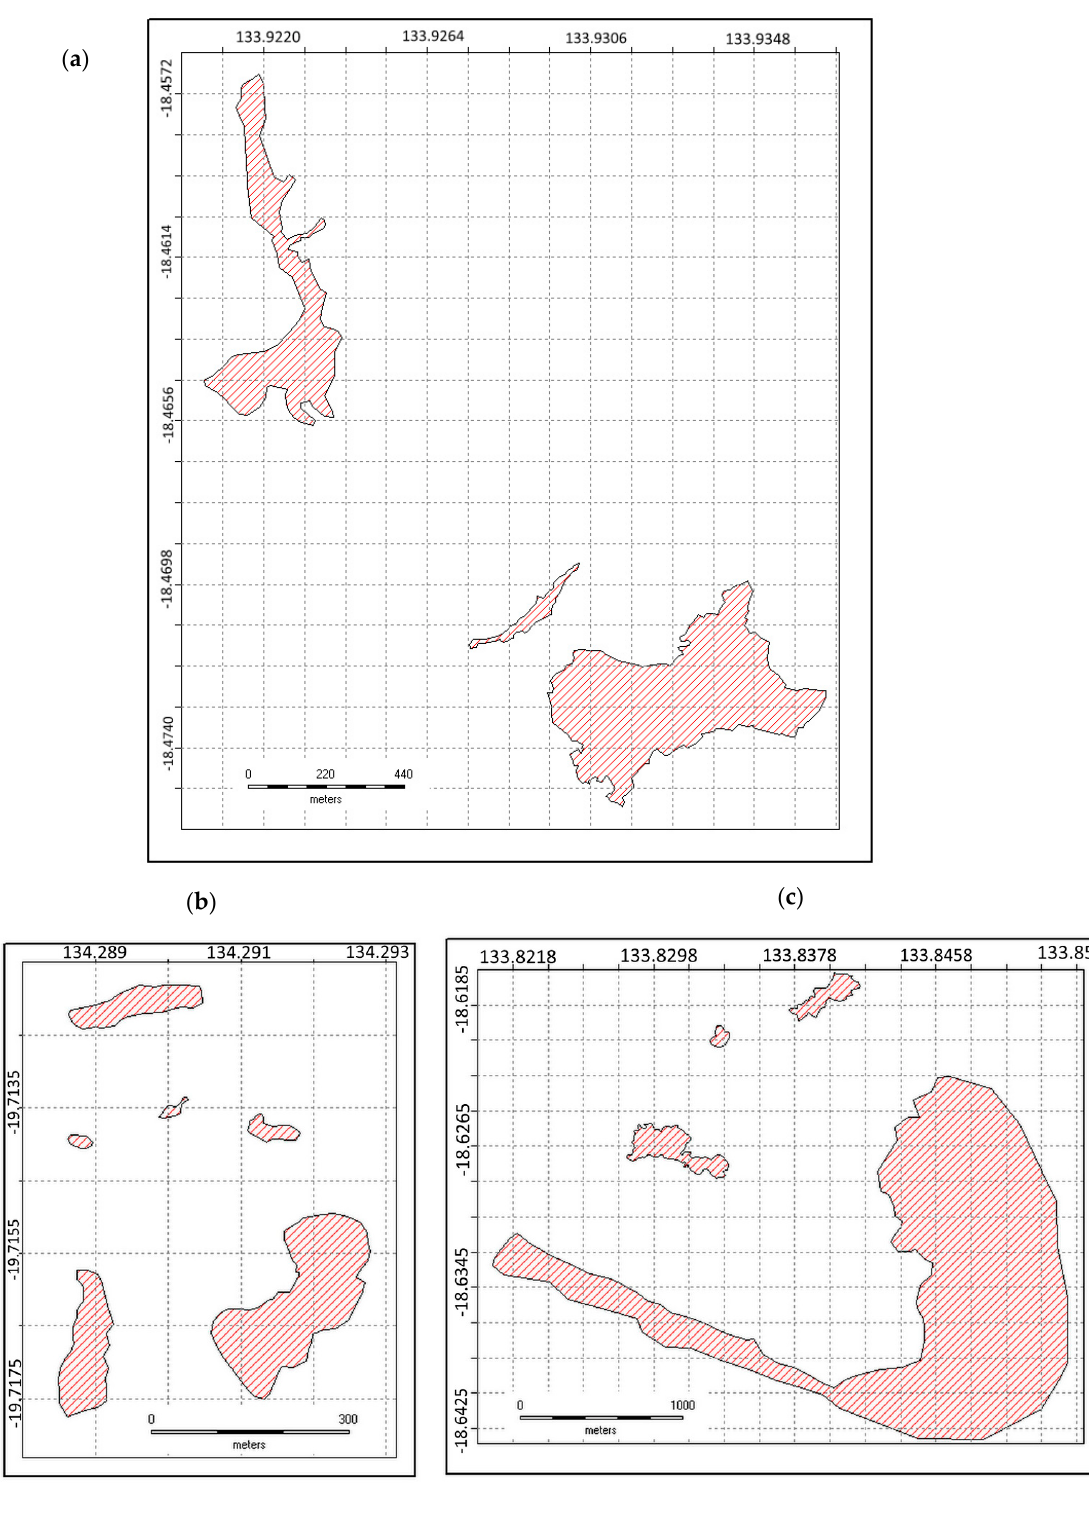
Figure 12. Rubber bush population distribution patterns: The extent and shape of infestations at ( a ) Helen Springs, ( b ) Tennant Creek, and ( c ) Muckaty paddock, all in the Barkly region. The populations in ( a , c ) above are located on flat grasslands, characteristic of the Barkly Tablelands, while ( b ) is located in a hilly, disused mining area. In all cases, the largest populations with larger stemmed maternal plants are located to the southeast of the extended expansion fronts.